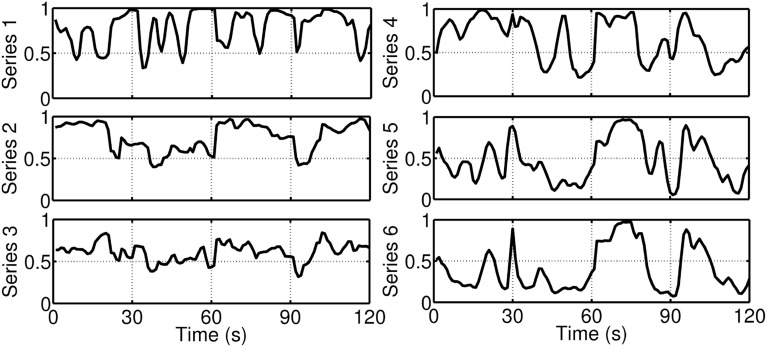
Example of six time-frequency based pairwise coherence measures (series) for one individual watching funny film clips. Series 1: ECG-EDA coherence (EDA region), Series 2: ECG-EDA coherence (ECG region), Series 3: RE-ECG coherence (ECG region), Series 4: RE-ECG coherence (RE region), Series 5: RE-EDA coherence (EDA region), Series 6: RE-EDA coherence (RE region). During the first 60 s, the participant was watching a film clip, which was rated as moderately funny. During the last 60 s, the participant was shown a funnier film clip.